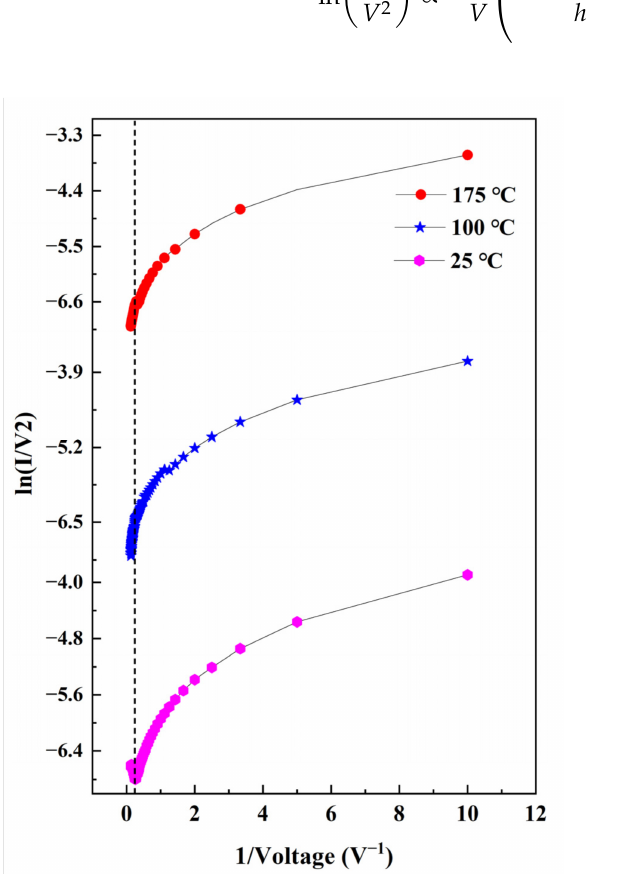
Figure 8. ln( I/V 2 ) vs. 1/V plot of the n-Ce:ZnO NL/p-BDD heterojunction at various